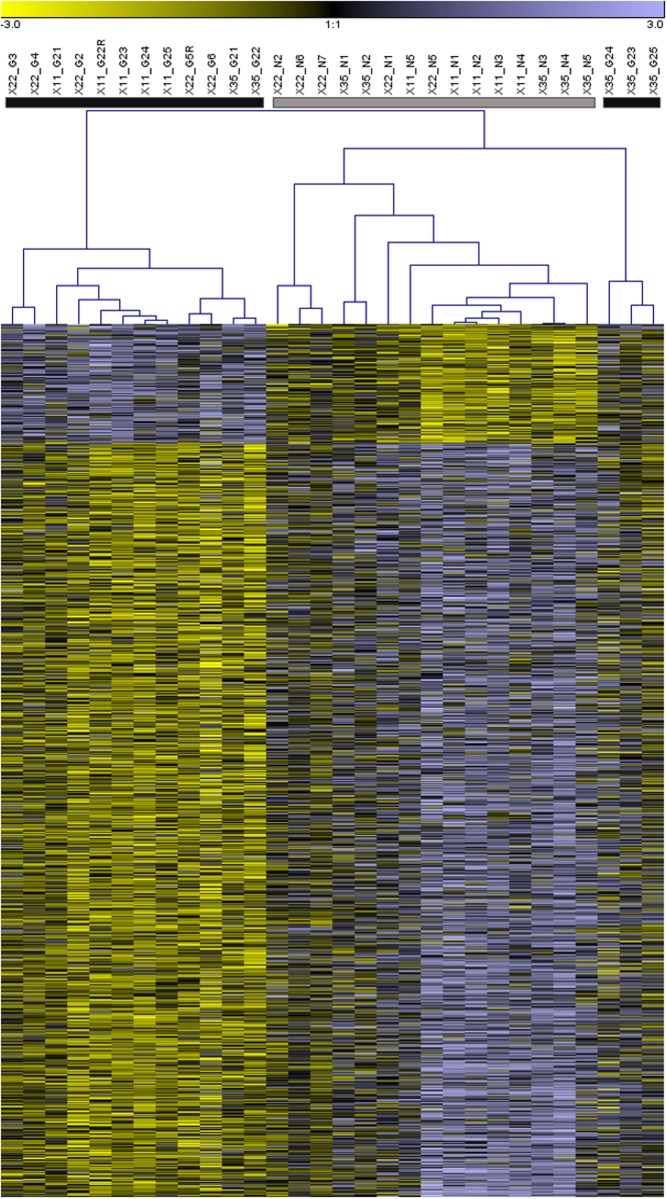
Hierarchical clustering of Atlantic salmon gene transcription profiles following juvenile rearing in unenriched and enriched hatchery environments.The heatmap depicts clustering of all 808 differentially transcribed genes, with the transcription profile of each individual represented by a column in the map. Grey and black color bars located above the columns correspond to individuals reared in unenriched and enriched environments, respectively. Above these bars, each profile is also labeled by family (X11, X22, X35), whether the individual was reared with gravel (G) or without gravel (N), and by individual identification number. For a given gene (i.e. row in heatmap) higher and lower gene transcript abundance, relative to the common reference sample, is indicated in purple and yellow, respectively.